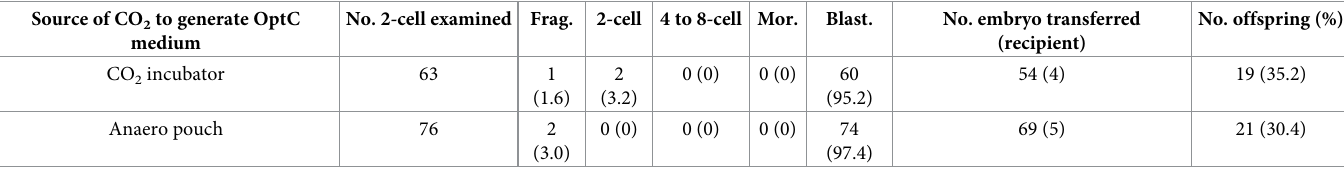
Frag.: Fragment; Mor.: Morulae; Blast.: